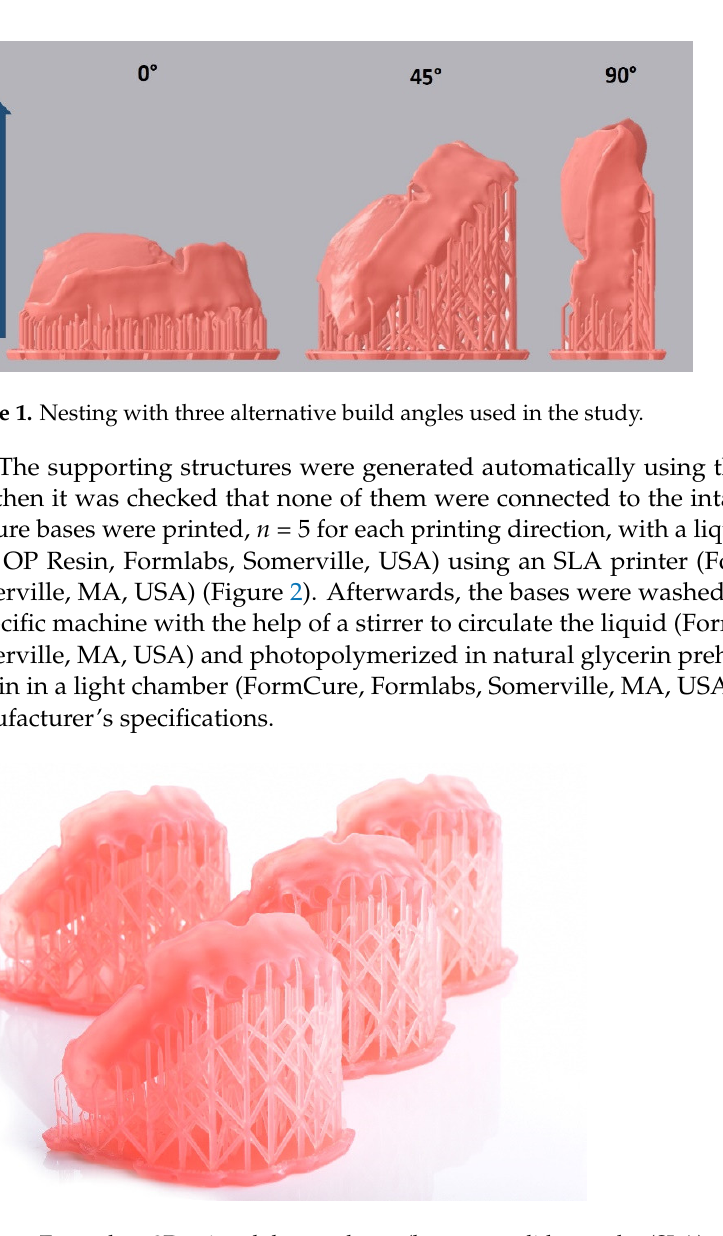
Figure 1. Nesting with three alternative build angles used in the study.